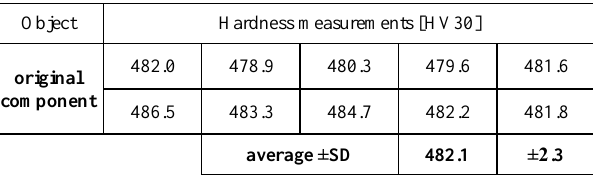
Table 3. Results of HV30 hardness measurements of snap hook from original belts